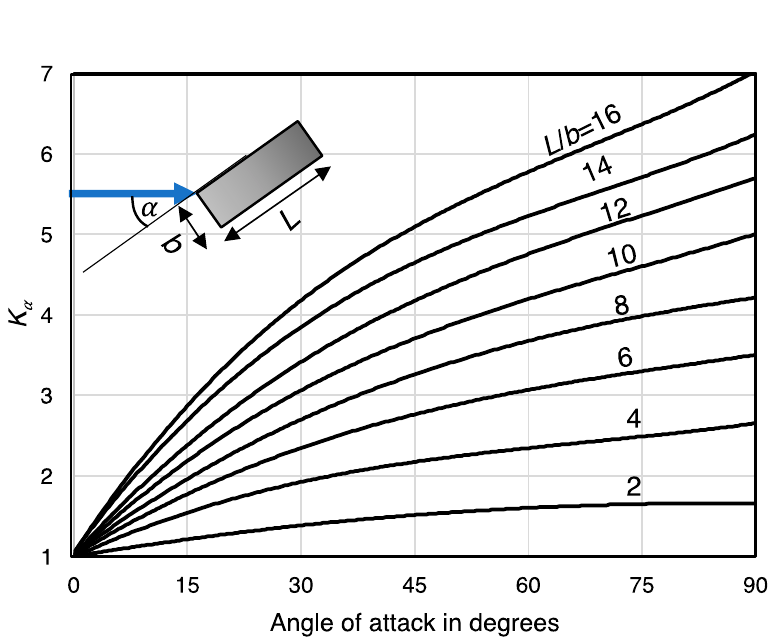
Figure 10. Design factor K α (according to Laursen and Toch [12]).